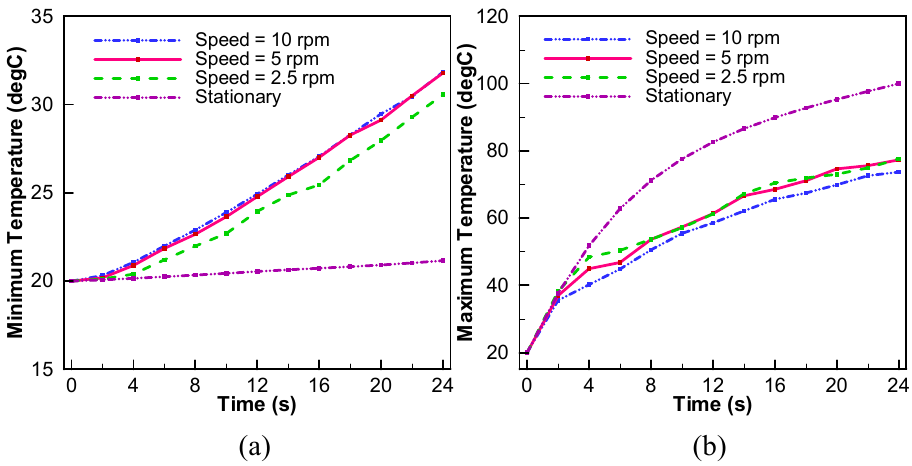
Figure 12. The minimum ( a ) and maximum ( b ) temperatures of the cubic shaped mashed potato heated with different speeds.